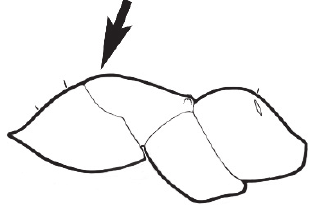
– Minor worker variable shades of brown or dark reddish-brown but not blackish-brown with dull, silky sheen; in profile, pronotum smoothly convex, mesonotum completes the curve without a median hump; erect setae on mesosoma often numerous and flexuous, length of longer setae ≥ greatest width of antennal scape (in relatively glabrous minor workers, appressed setae on mesosoma long and conspicuously pale); major worker similar to